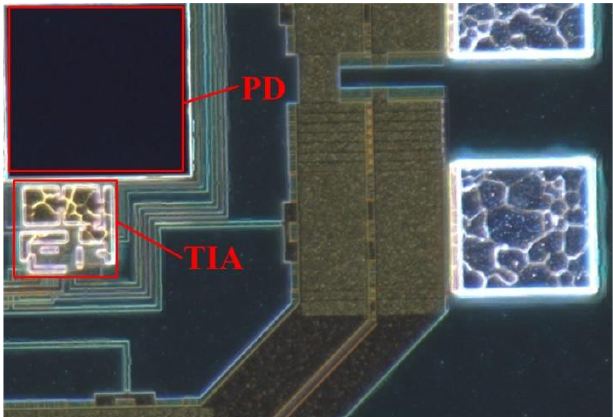
Figure 4. Microphotograph of the fabricated integrated optoelectronic sensing SoC.